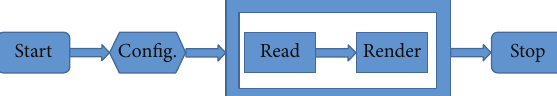
Figure 2: Operational Layout for the Kinect LabVIEW toolkit.